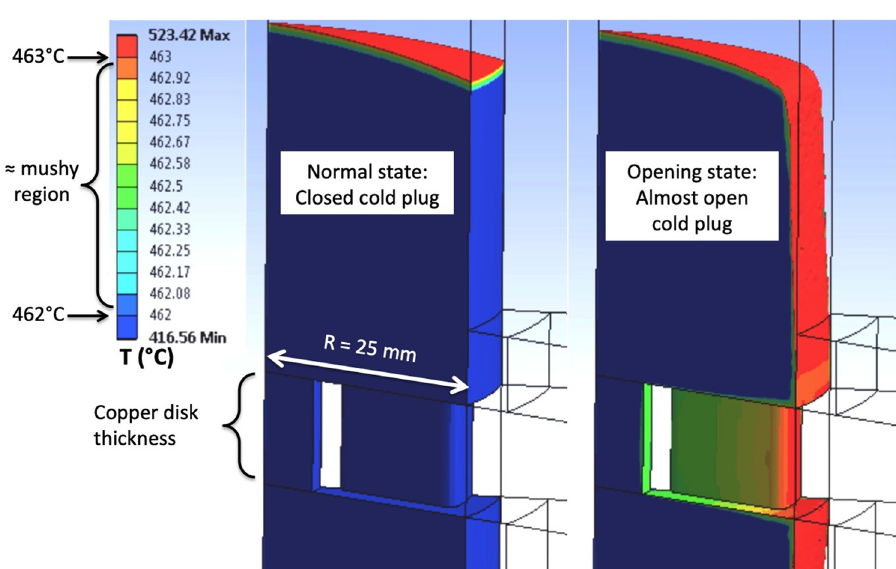
Fig. 11. Energetic numerical ANSYS simulations of the cold plug experiment in SWATH. The left fi gure corresponds to the “ zero time ” , the instant of the cooling and heating shutdown. The right fi gure is for the instant where the liquid salt fi nd a path against the wall ( t =378 s). With the temperature color scale used, only the solid salt and a thin mushy region represented with a fi ne color scale varying with temperature are shown, the liquid covering salt does not appear in the fi